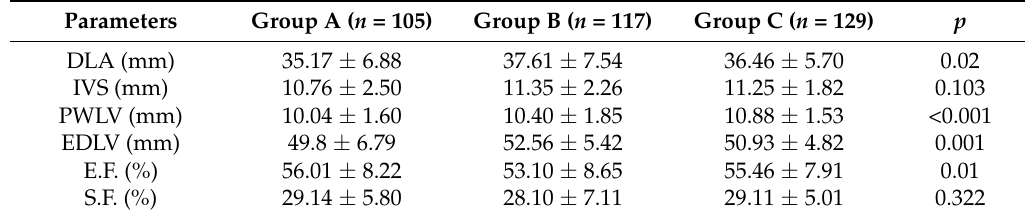
Table 4. Echocardiography data in different study